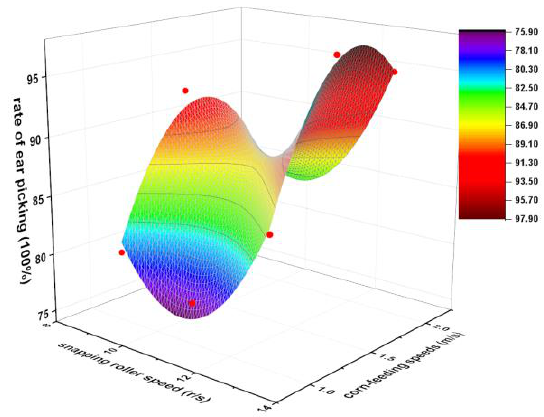
Figure 11. Visual diagram of picking rate and its influencing